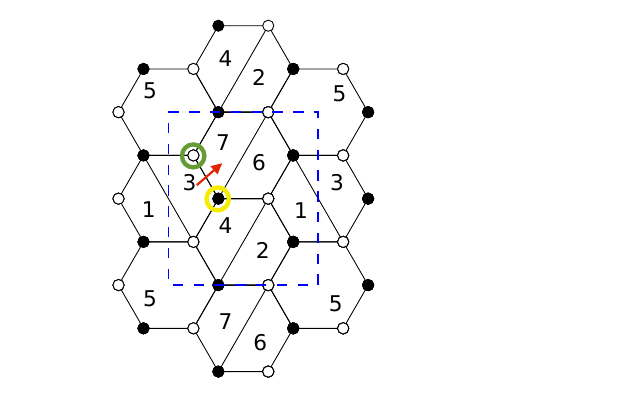
Figure 19 . The dimer of the PdP 4 singularity. The square represents (a choice of) the fundamen- tal